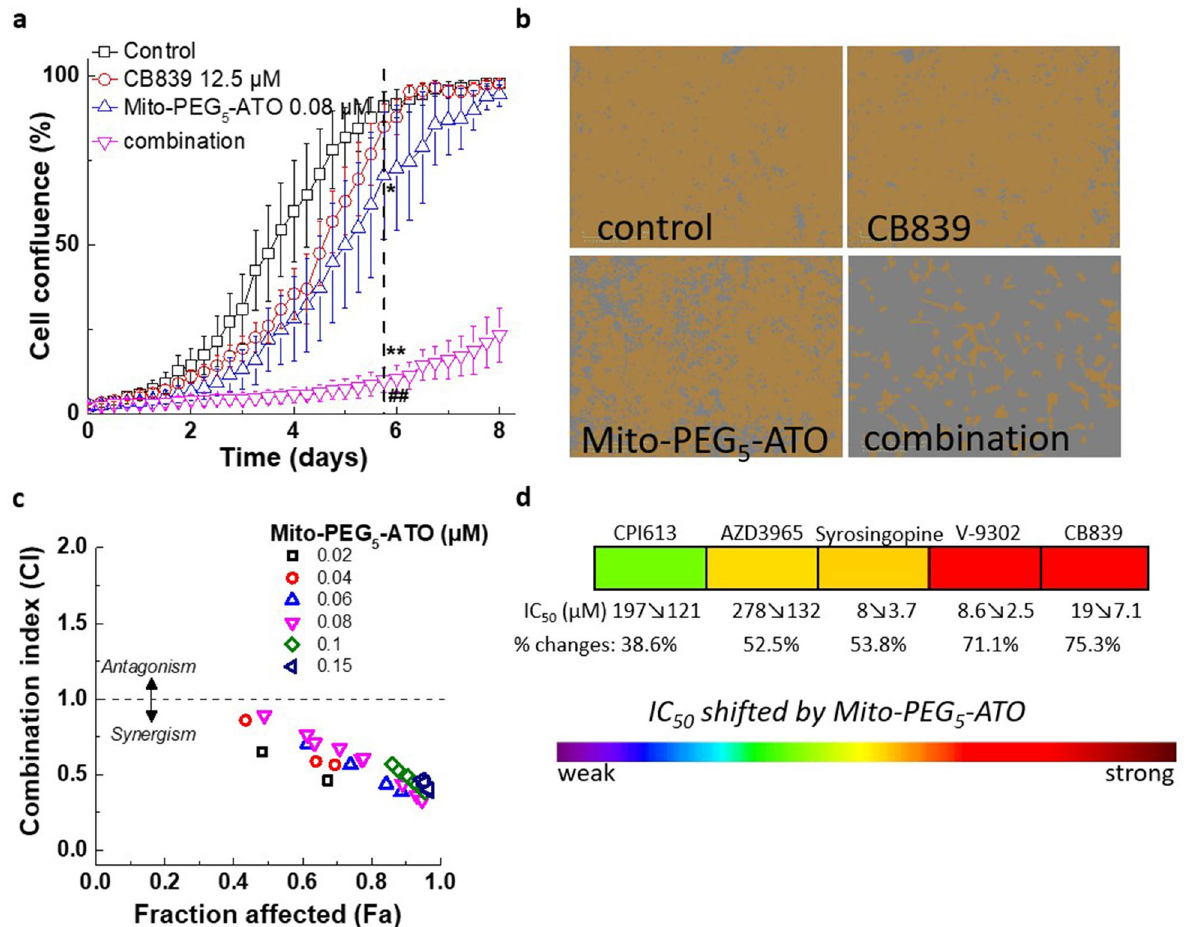
Figure 7. Synergistic inhibition of cell proliferation by Mito-PEG 5 -ATO and CB-839 in human pancreatic cancer (MiaPaCa-2) cells. ( a ) MiaPaCa-2 cells were treated with Mito-PEG 5 -ATO alone and in the presence of Mito-PEG 5 -ATO and CB-839 and cell growth was monitored continuously. ( b ) Representative cell images are shown as a segmentation mask illustrated in brown when control cells reached ~ 90% confluence (vertical dashed line). ** p < 0.01 vs control. ## p < 0.01 vs Mito-PEG 5 -ATO or CB-839 alone. ( c ) Cell confluence (control cells reached ~ 90% confluence) is plotted against concentration for the synergistic calculation. ( d ) Heat map showing the enhanced effect of redox and MCT inhibitors in sensitizing the antiproliferative effect of Mito- PEG 5 -ATO. Deep red indicates strongest synergy (IC 50 decreased from 19 µM to 7.1 µM, 75.3% inhibition) and deep green indicates weakest synergy (IC 50 decreased from 121 µM to 91 µM, 38.6%